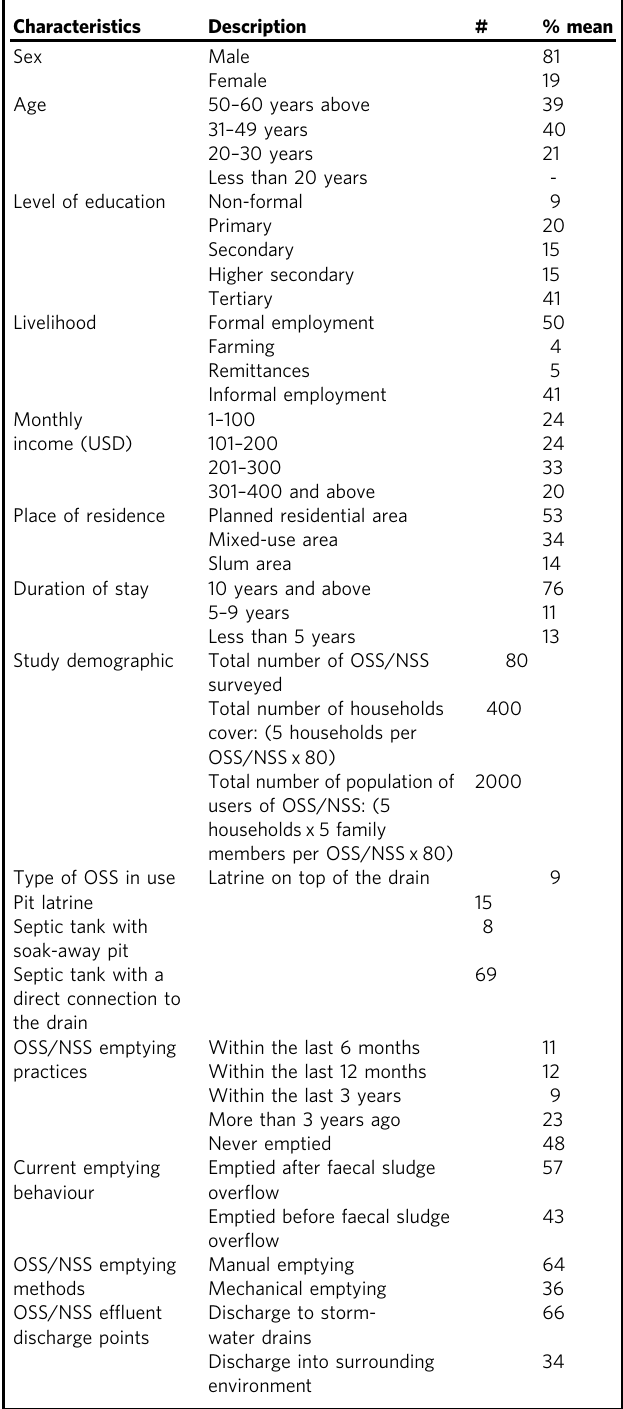
Table 2 Respondents pro fi les and characteristics of their onsite sanitation systems as well as their emptying